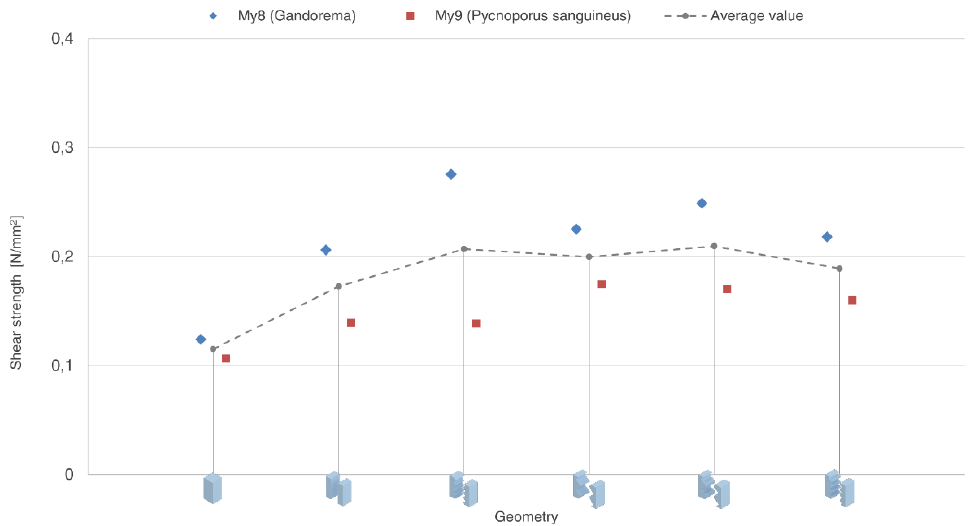
Figure 6. Shear strength to geometry diagram. Test specimen geometries from left to right: Sch0, Sch1, Sch2, Sch3, Sch4, and Sch5.